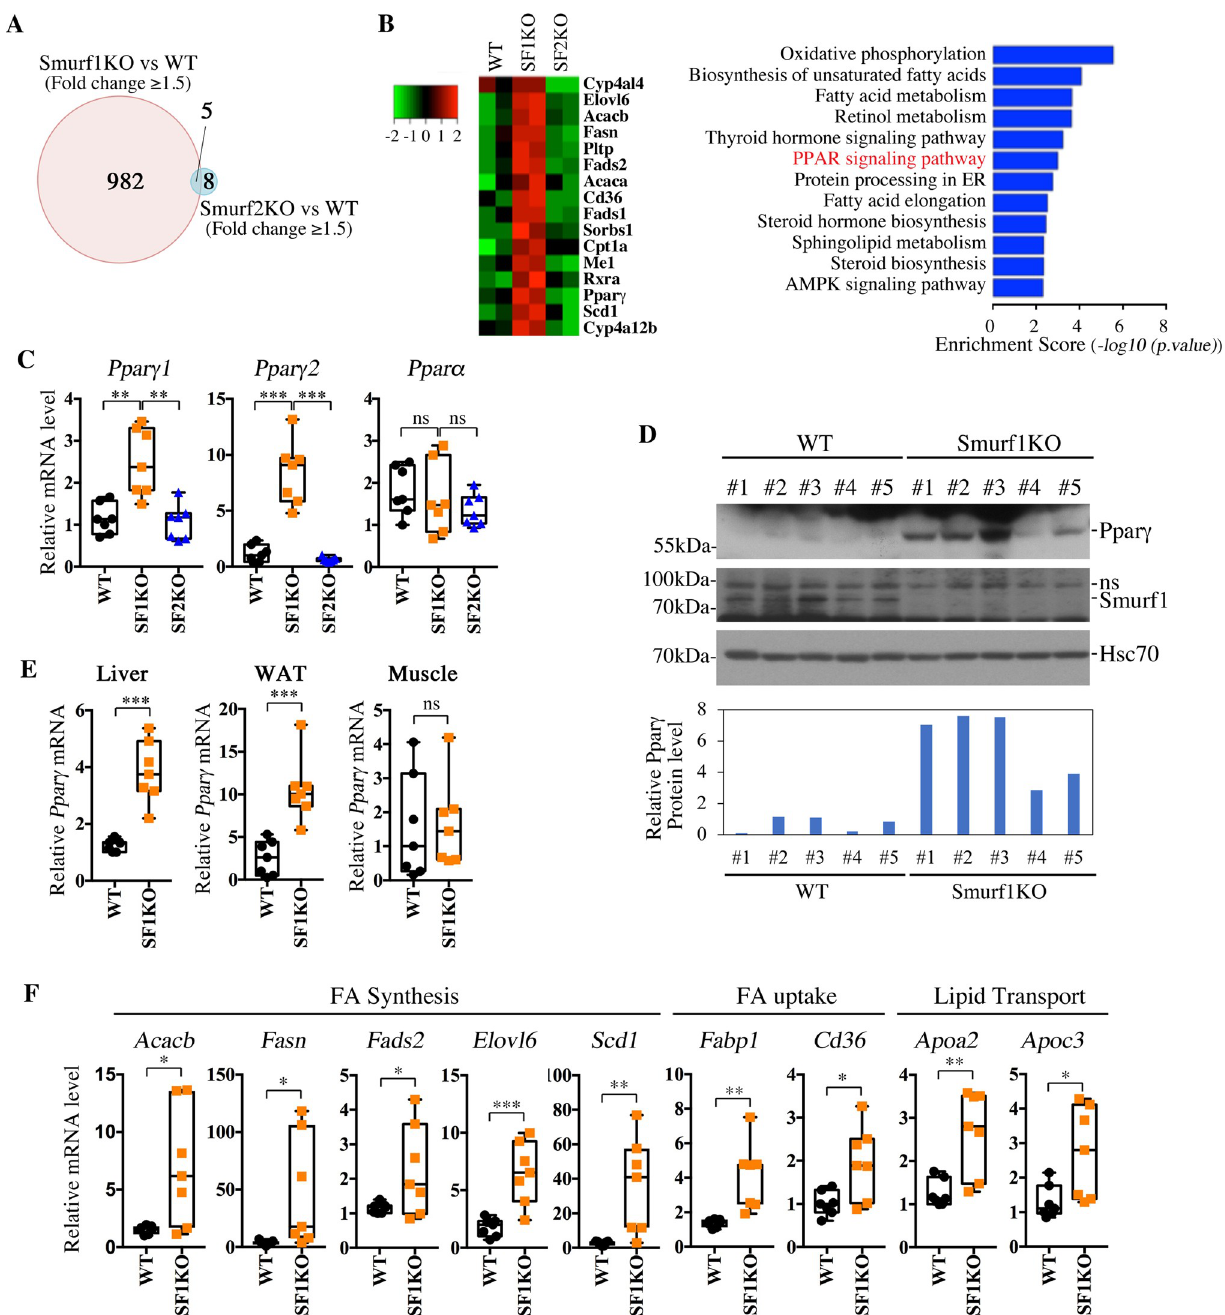
Fig 3. Up-regulation of PPAR γ and other relevant lipid metabolic pathways associated with Smurf1 loss. (A) Venn diagram of genes that were differentially expressed (fold > 1.5, FDR < 0.1) in Smurf1KO and Smurf2KO livers from the BL background relative to their WT counterparts at 11 months of age. For a detailed list, see S3 Table. (B) Heat map of a group of lipid metabolism–related genes that were differentially expressed in Smurf1KO livers and the KEGG pathway analysis of differentially expressed genes from BL-Smurf1KO livers. Enrichment score ( p -value ( − log10)) is indicated on the x-axis. (C) qRT-PCR analyses of Ppar γ 1 , Ppar γ 2 , and Ppar α in livers from BL-WT, Smurf1KO, and Smurf2KO mice ( n = 7 per group). (D) Western blot showing the increase of the PPAR γ protein in livers of BL-Smurf1KO mice. Quantitation of PPAR γ expression against loading control Hsc70 is shown at the bottom. (E) qRT-PCR analyses showing the increase of total Ppar γ mRNA in livers and epididymal WAT but not skeletal muscle of BL-Smurf1KO mice, n = 7 per group. (F) qRT-PCR analyses showing up-regulation of a group of PPAR γ target genes in livers of BL-Smurf1KO mice ( n = 7 per group). Data from qRT-PCR are presented using box and whisker plot showing all points; centerline represents the median. All mice were analyzed at 9–11 months of age, and statistical significance of difference between WT and Smurf1KO is indicated as � p < 0.05, �� p < 0.01, and ��� p < 0.001. Original raw data can be found in S1 Data. BL, mixed black Swiss × 129/SvEv background; FDR, false discover rate; Hsc70, heat shock 70 kDa protein 8; KEGG, Kyoto